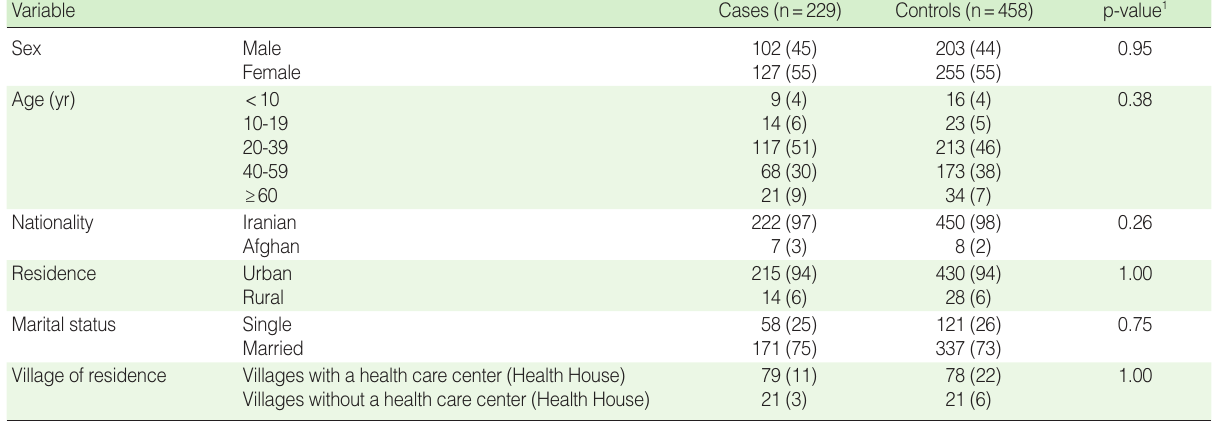
Table 1. Demographic characteristics of cases and controls in the 2011 cholera outbreak in Alborz Province, Iran Variable